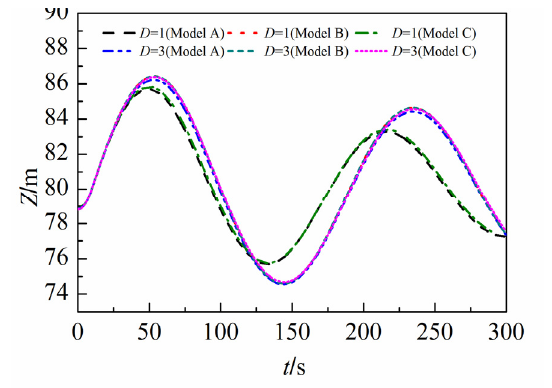
Figure 31. Wind speed simulated by three models.